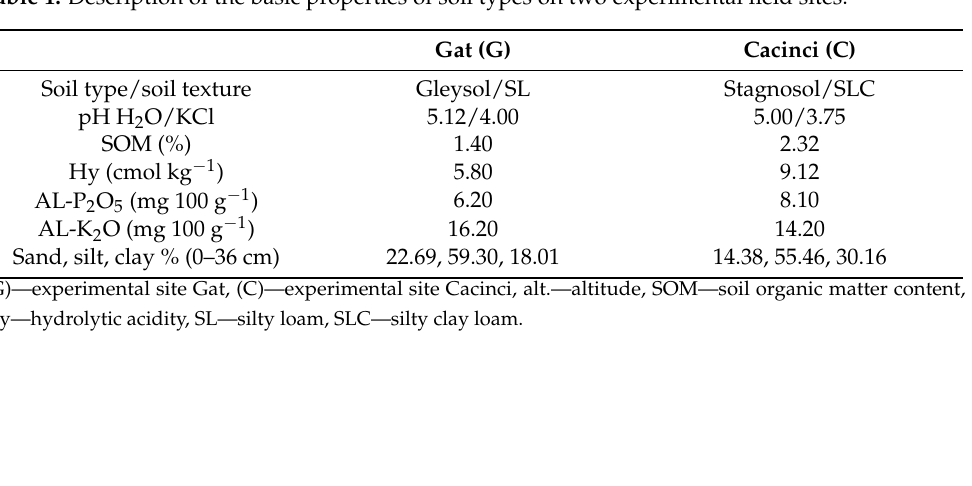
Table 1. Description of the basic properties of soil types on two experimental field